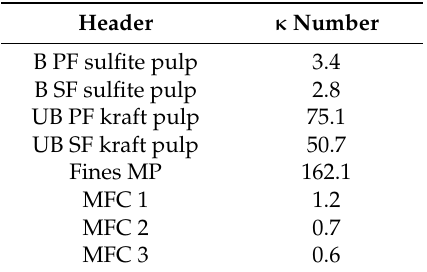
Table 2. κ numbers of the different cellulosic